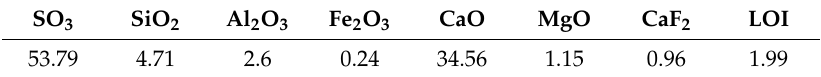
Table 3. Chemical composition of fluorgypsum (wt.%).